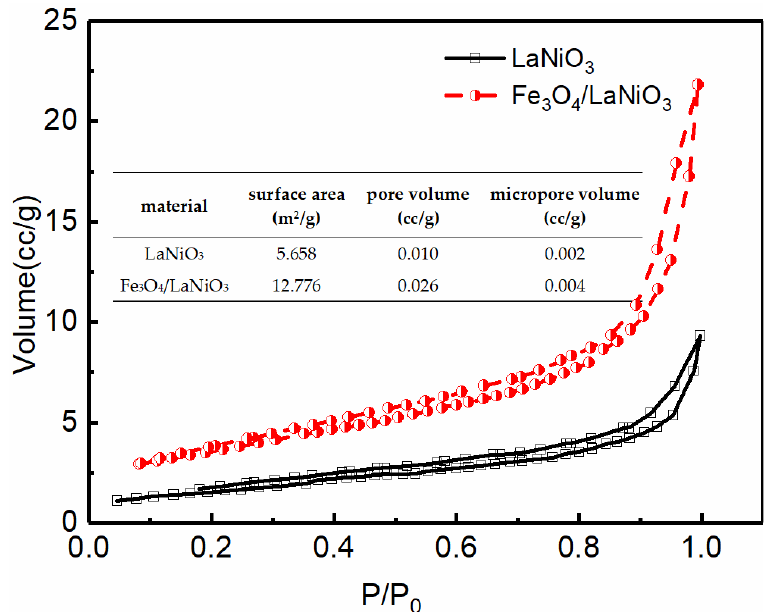
Figure 4. N 2 physical adsorption isotherms for LaNiO 3 and Fe 3 O 4 /LaNiO 3 catalysts. Table 1. Elemental Composition (%), Atomic Ratio Total Humic Acid (%), Water Humic Acid, and E 4 /E 6 Ratio of WC, AWC, ALC and